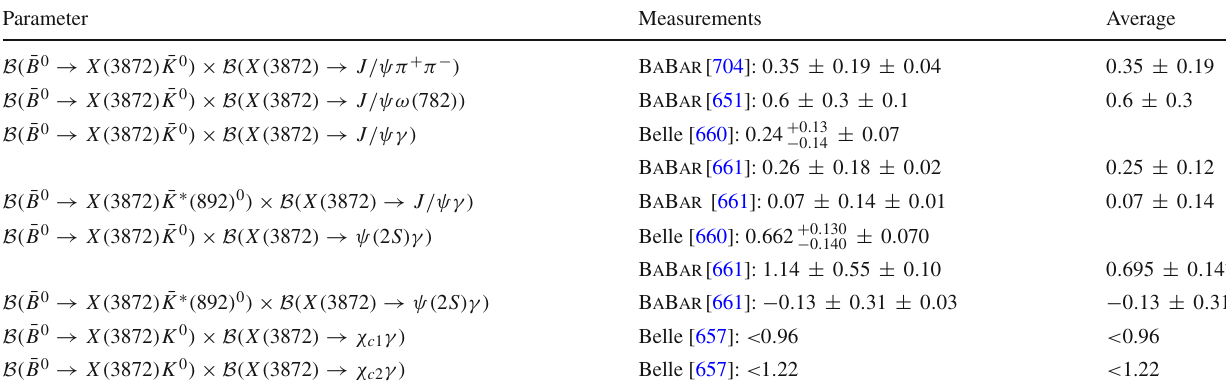
Table 129 Decays to X ( 3872 ) [ 10 − 5